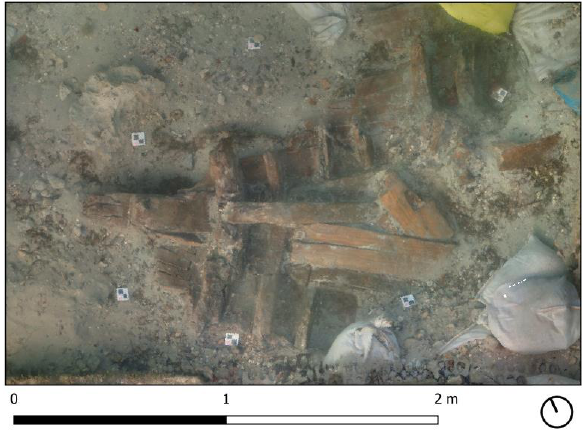
Figure 10 . Orthoimage of the aft part of the shipwreck, generated via free-net adjustment after the archaeological categorization. In red, the portion of the analysis of Figure 11.